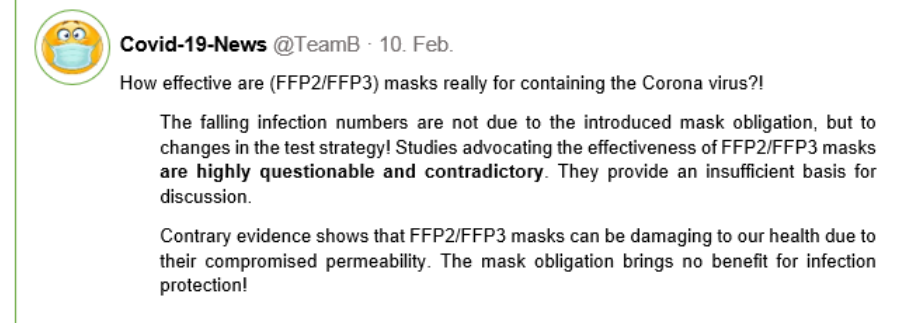
Figure A4. Conspiracy-theoretical Posting Team B. Note. Predictor media content: conspiracy-theo-